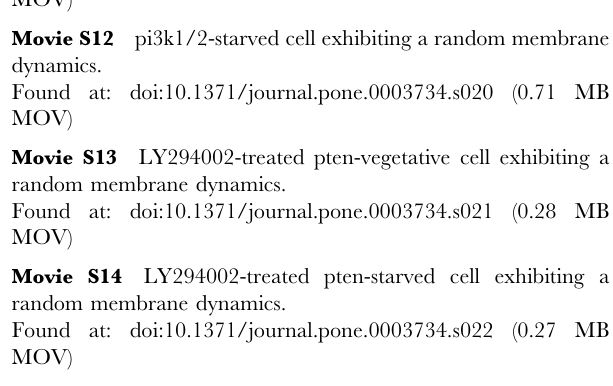
Figure S7 Clustering analysis of autocorrelation function. We first subject autocorrelation function (ACF) to Fourier transform to obtain the three parameters, AS , AL , and AR . We then conduct clustering analysis of ACF based on the obtained parameters. We show the clustering tree of wild-type vegetative